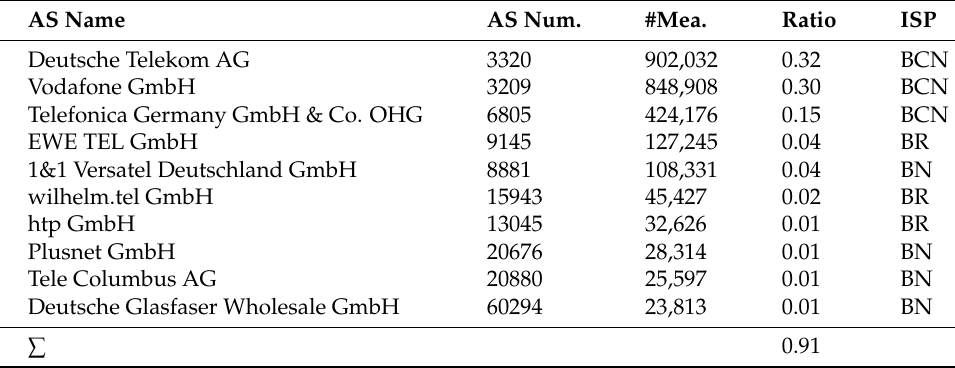
Table 4. Ten most seen ASNs at Hamburg location in August